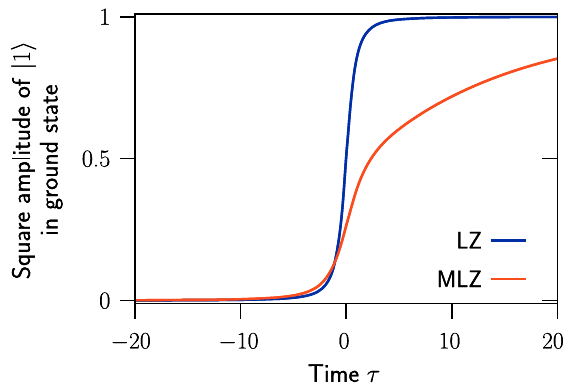
FIG. 7. Modulus square of the amplitude coefficient of j 1 i for the ground state of the Landau-Zener and MLZ models. We plot the coefficient as a function of time τ for η ¼ 1 and ω ω 0 . 1 . For the MLZ model, the value is substantially 2 ¼ 3 ¼ different from 1 for large values of τ . This indicates that a pure adiabatic evolution will not result in a NOT gate of the qubit